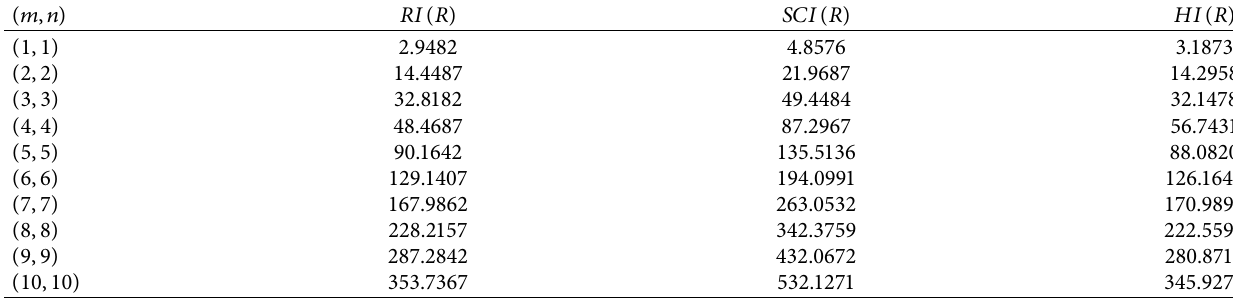
Table 4: Connection between RI ( R ) , SCI ( R ) , and HI ( R ) .